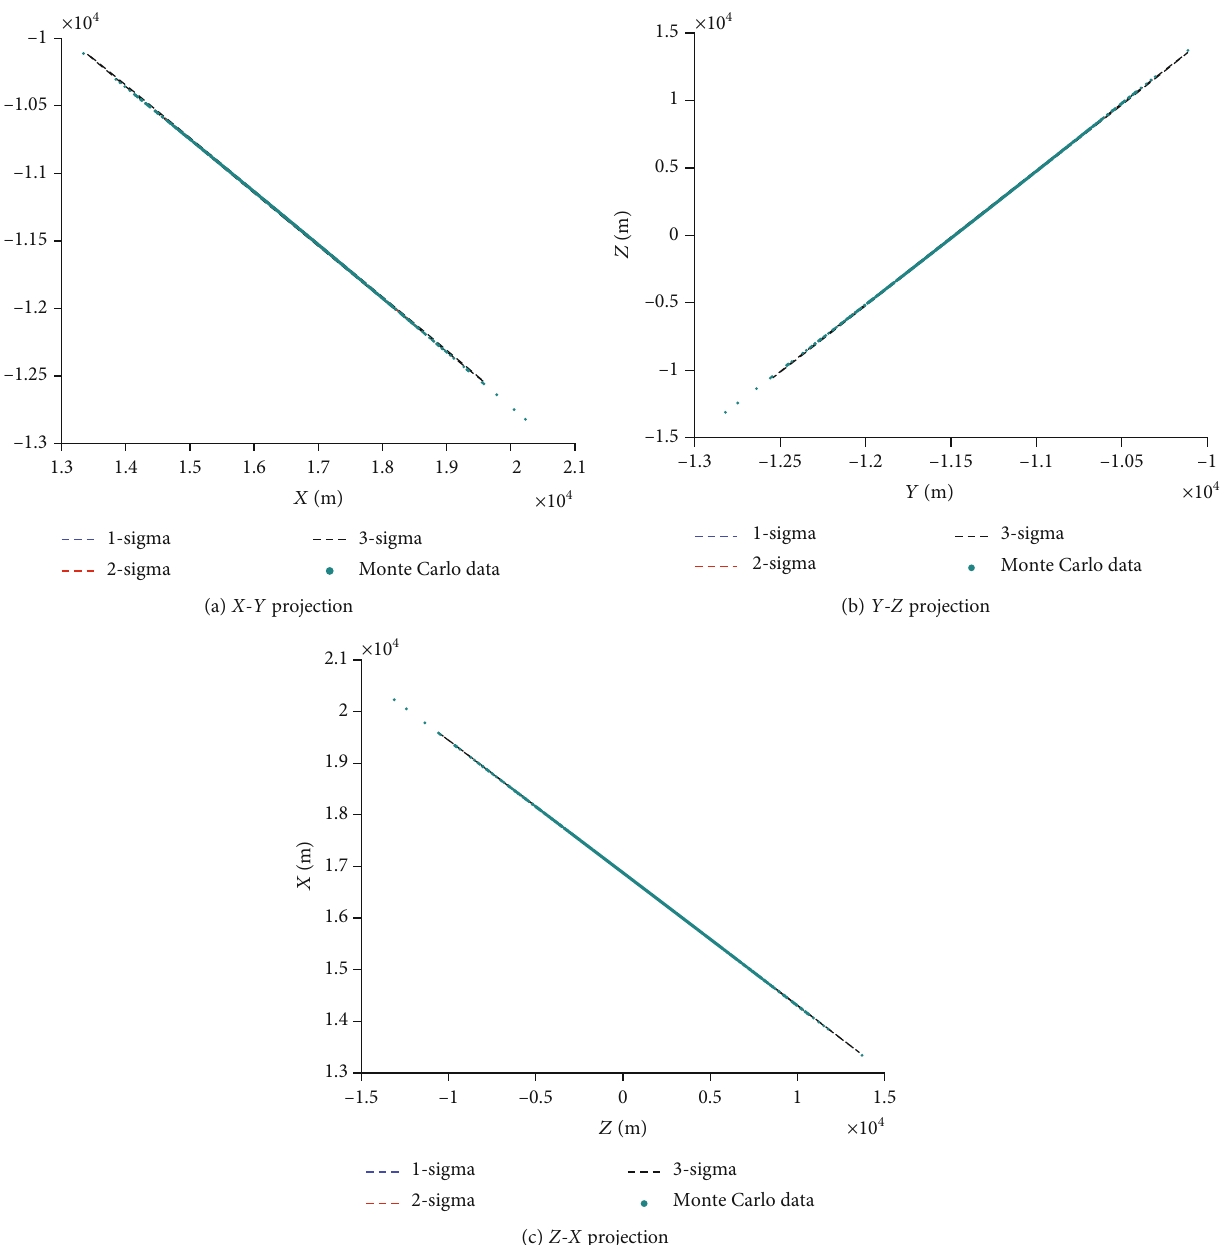
Figure 10: Error ellipsoid projection of Monte Carlo simulation results in the Mars model varying initial